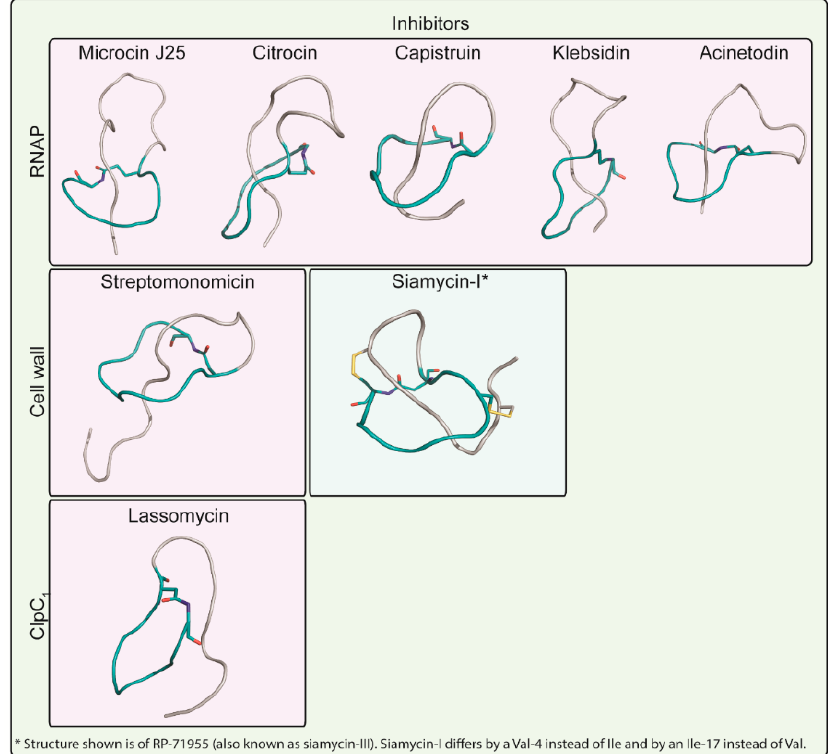
Figure 5. Structures of lasso peptides with a known molecular target. Microcin J25, citrocin, capistruin, klebsidin, and acinetodin are all lasso peptides that target RNA polymerase (RNAP). Streptomonomicin and siamycin-I are known lasso peptide inhibitors of the bacterial cell wall. Lassomycin is the only lasso peptide known to inhibit the ClpC1 unit of the ClpC1P1P2 protease complex. All the lasso peptides in purple boxes are class II lasso peptides with no disulfide bridges, whereas only siamycin-I, in a blue box, is a class I lasso peptide with two disulfide bridges, which are shown in yellow. The side chains of the amino acids involved in macrolactam formation are colored according to their elemental composition.